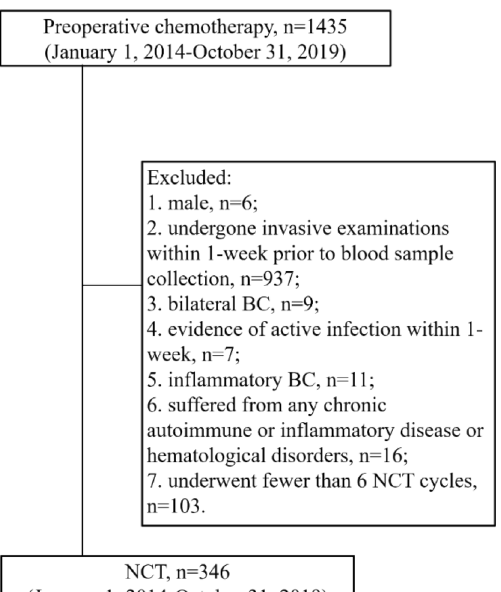
Figure 1. Patient flow diagram. BC breast cancer, NCT neoadjuvant